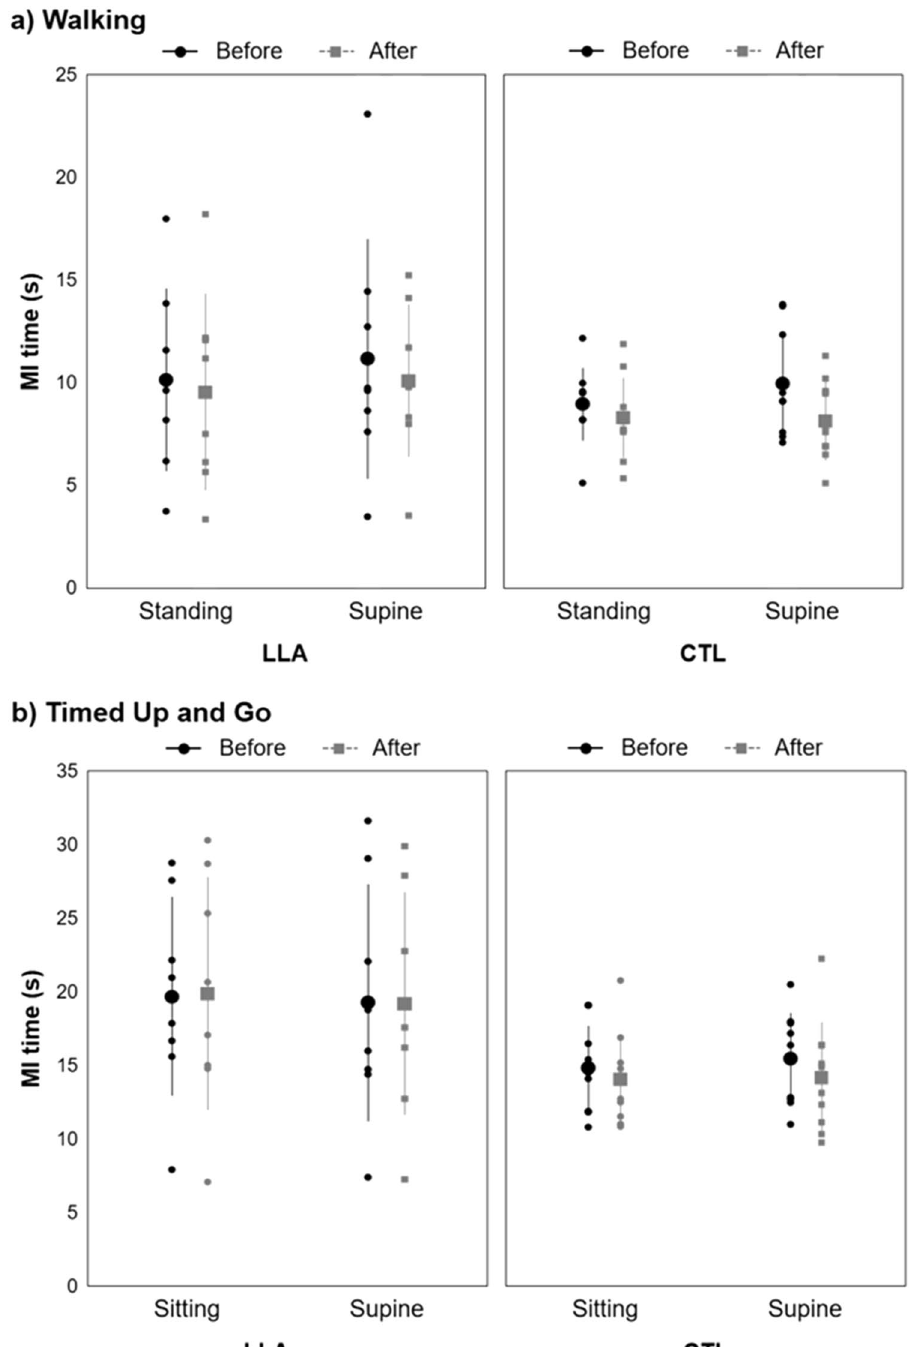
Figure 1. Mean (± SD) MI times (in seconds) in the LLA (n = 8) and CTL (n = 10) groups for ( a ) the walking task, in the standing and supine positions, before and after AE, and ( b ) the TUG task, in the sitting and supine positions, before and after AE. Small dots and squares represent individual data, large points and squares, mean data, and bars, SD. In the walking task, there was a significant Position effect ( p = .030) with shorter MI times in the standing-congruent position than in the supine-incongruent position. There was also a significant Order effect ( p = .009) with shorter MI times after AE than before AE. In the TUG task, MI times tended ( p = .080) to be longer in the LLA group than in the CTL